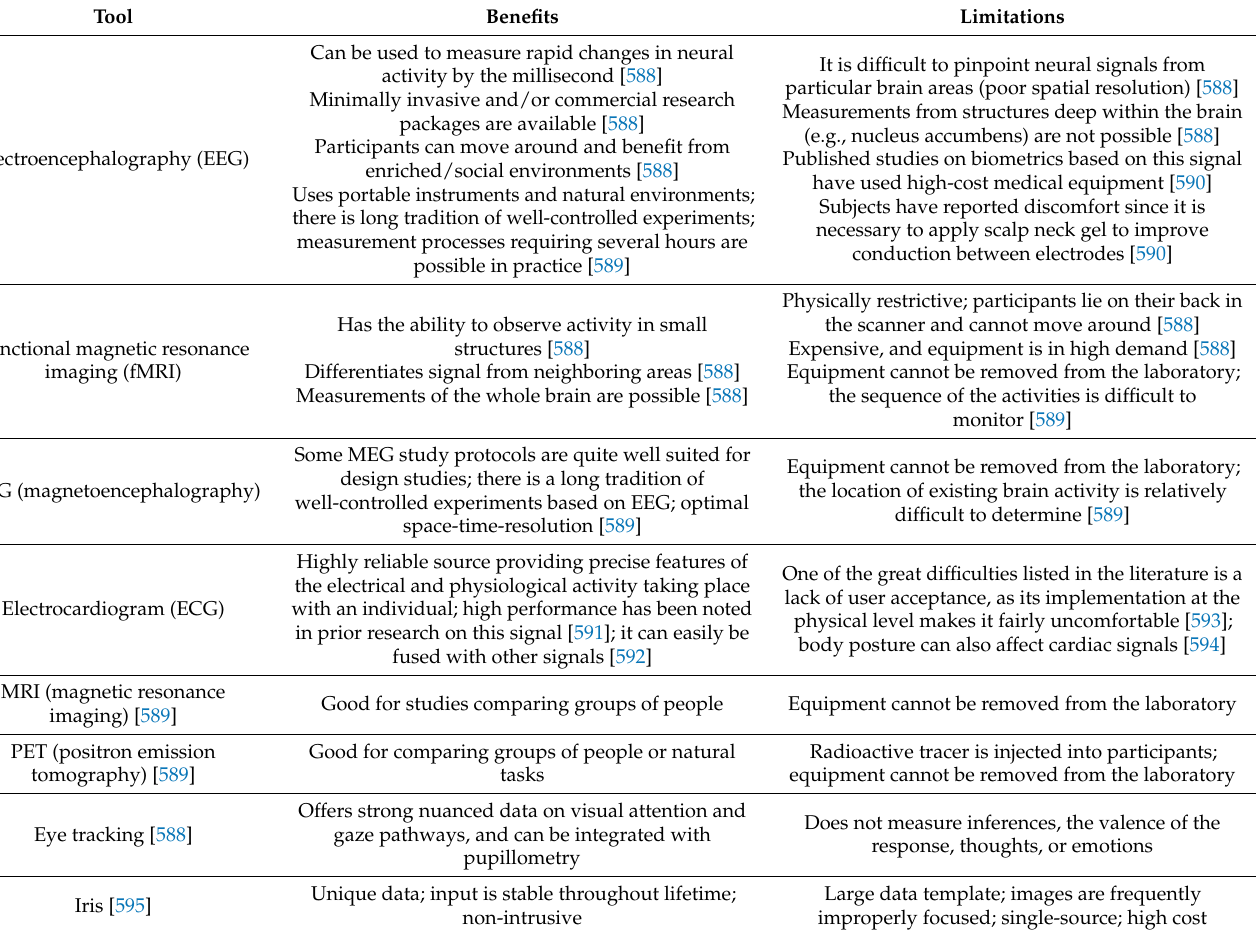
Table 9. Benefits and limitations of biometric